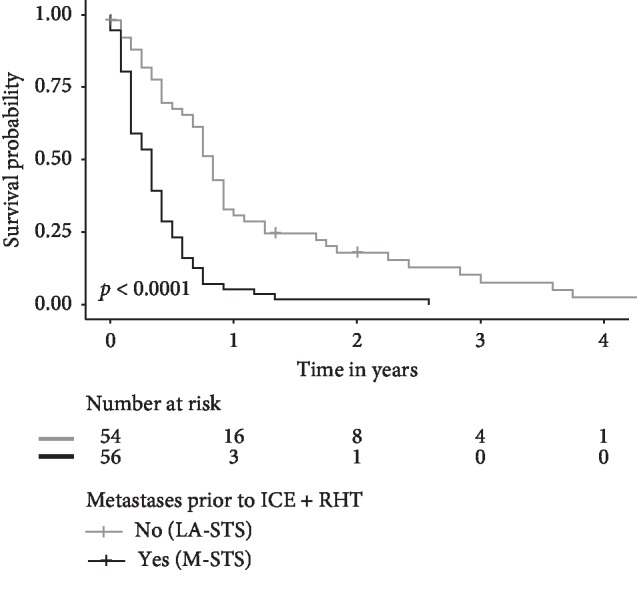
Kaplan–Meier estimates of progression-free survival for patients with (n = 56, M-STS) and without (n = 54, LA-STS) metastases prior to initiation of ICE + RHT. The p value was assessed by the log-rank test.